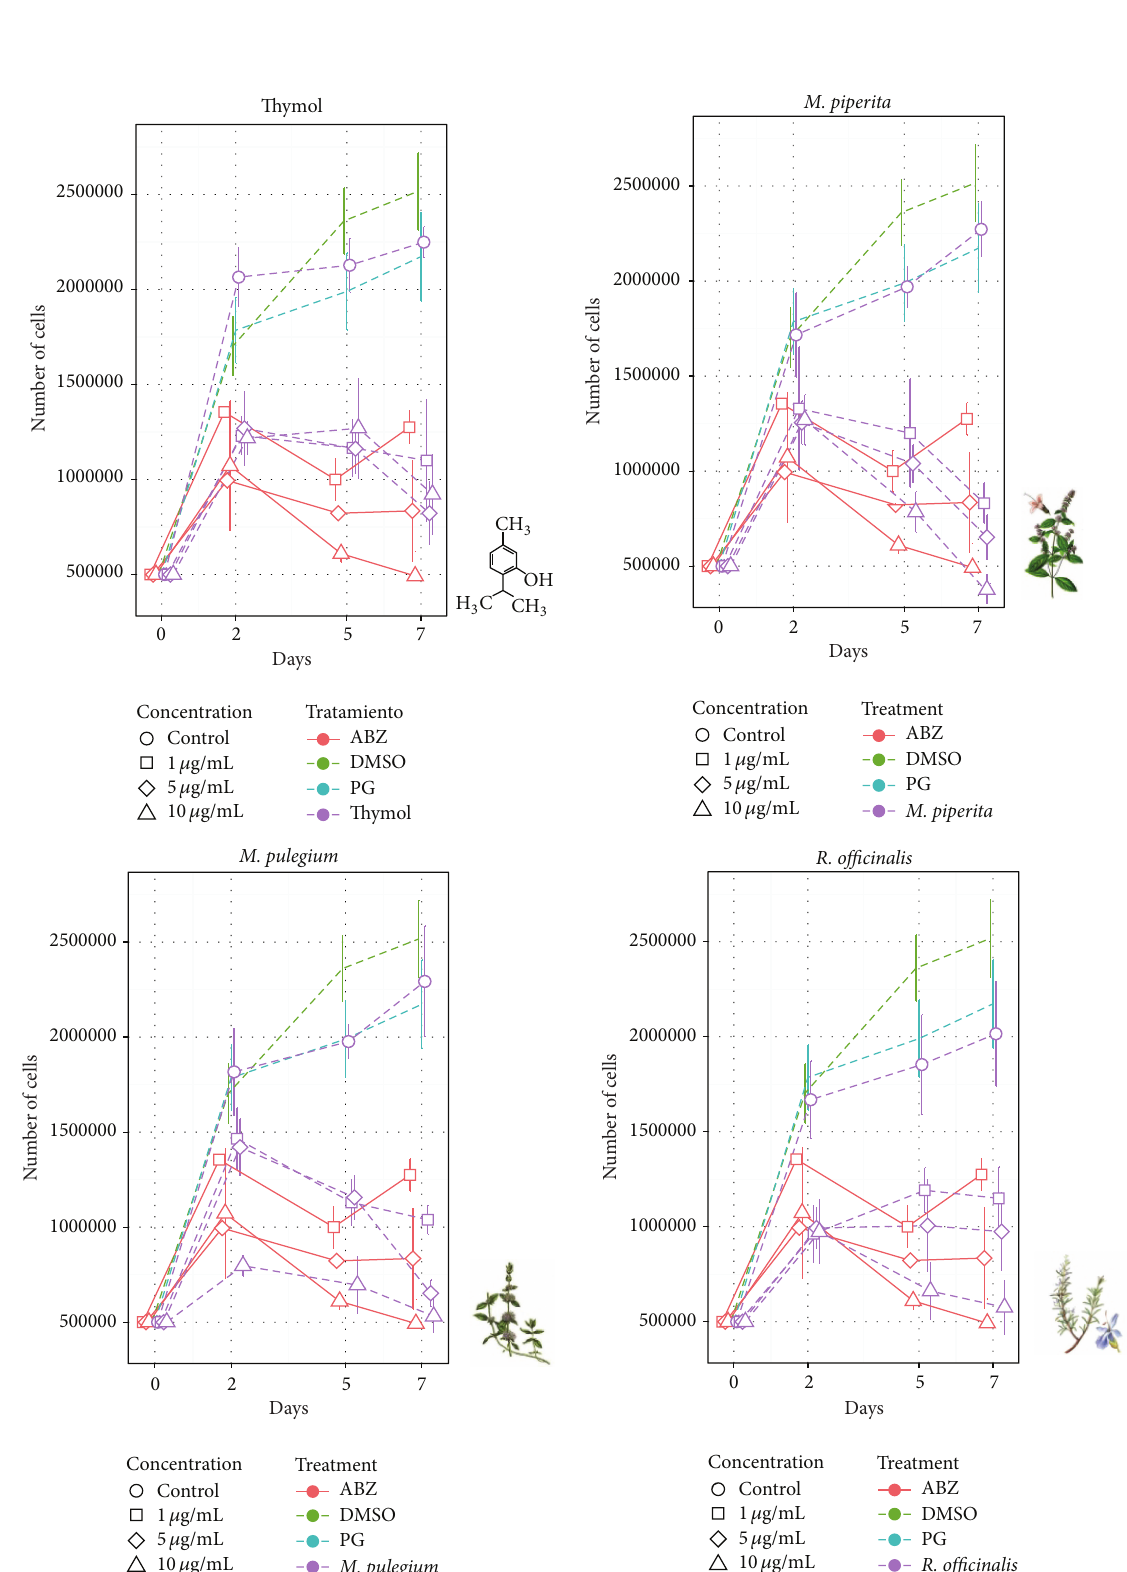
Figure 1: Survival of E. granulosus larval cells after treatment with M. pulegium , M. piperita , R. officinalis essential oils and thymol. Each point represents the mean percentage of vital cells from three different experiments ±